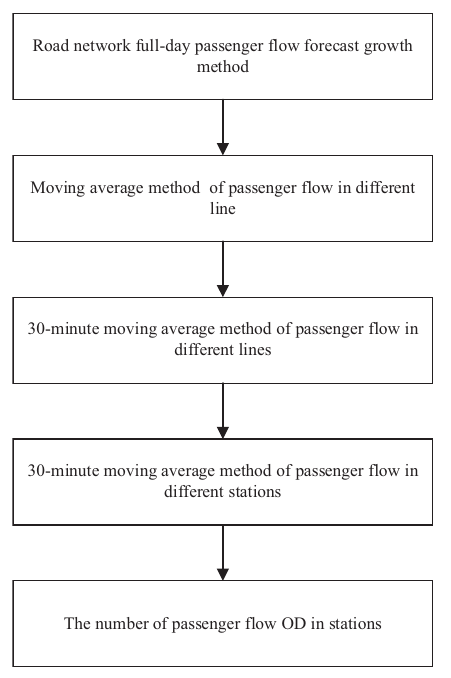
Figure 2. Process of passenger fl ow prediction model processing during the